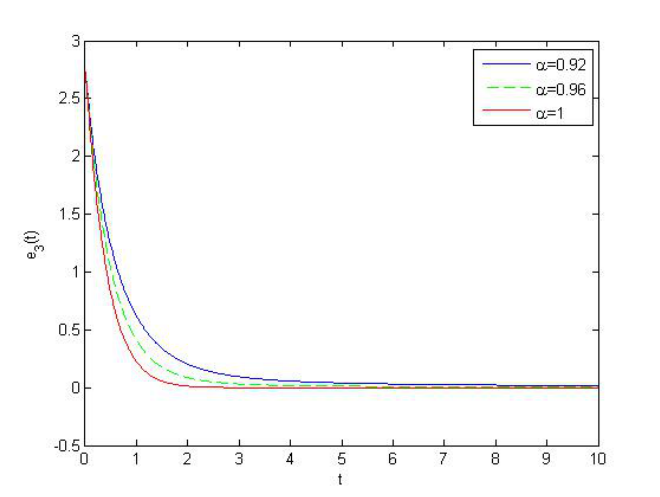
Figure 7. The error state curves between the drive system and response system with different orders q = 0.92, 0.96,